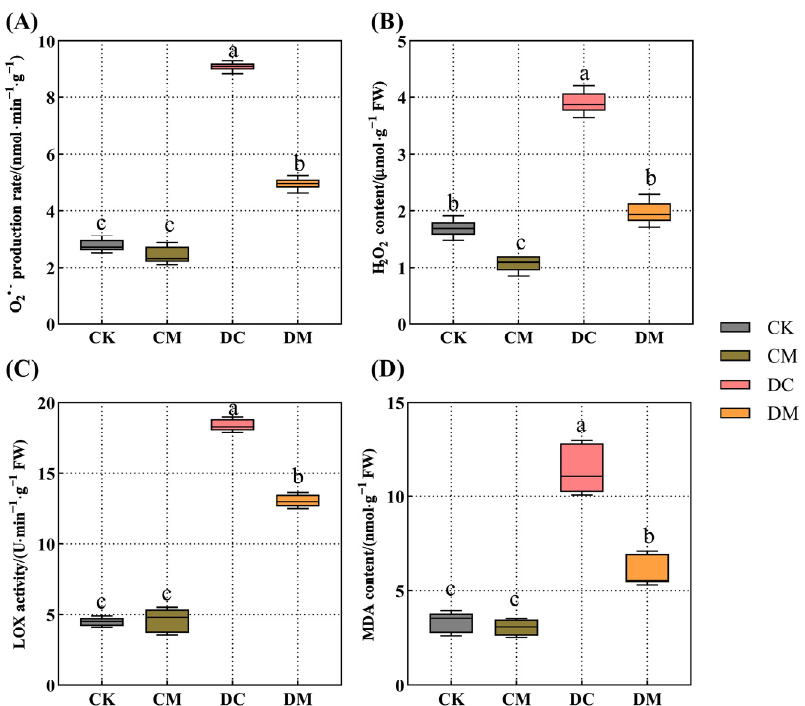
Figure 2. Effect of exogenous melatonin on lipid peroxidation and ROS under drought stress. ( A ) O 2 − production rate; ( B ) H 2 O 2 content; ( C ) LOX activity; and ( D ) MDA content.